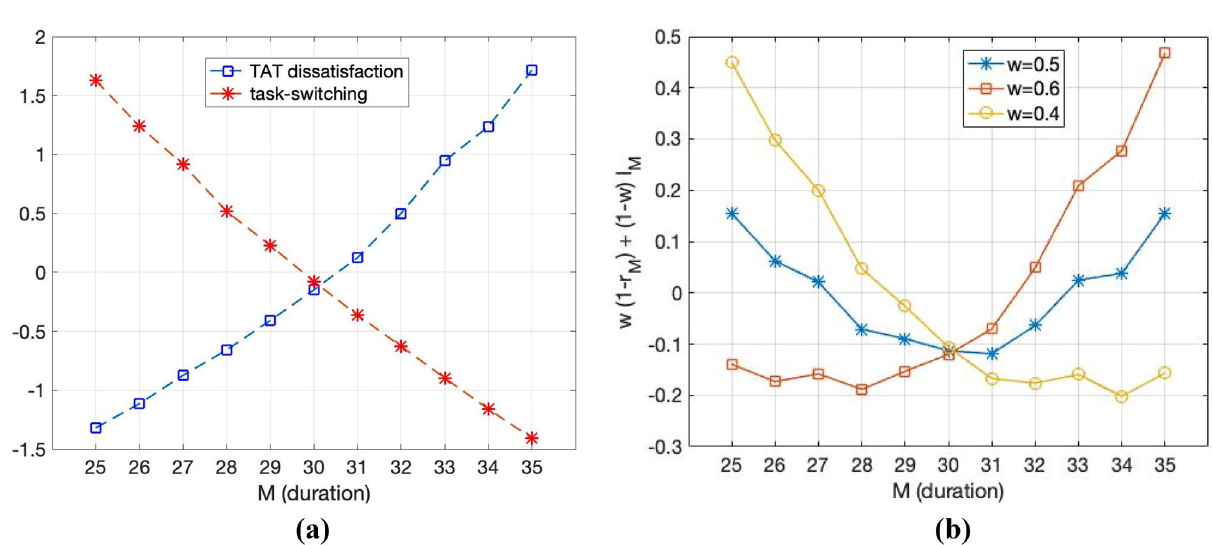
Figure 4. ( a ) Graph with normalized variables 1 − r M and l M . For each M (duration), the red line shows the number of tasks and the blue line denotes the proportion of the samples that exceeded the TAT, 60 min. ( b ) Linear combination of task switching and TAT dissatisfaction reflecting different weights ( w )